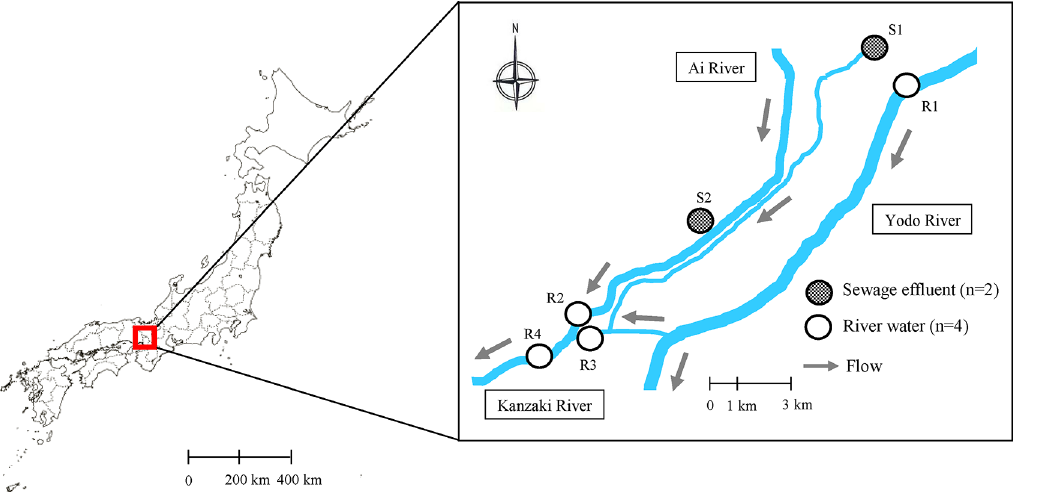
Fig 1. Locations of sampling sites in the Yodo River